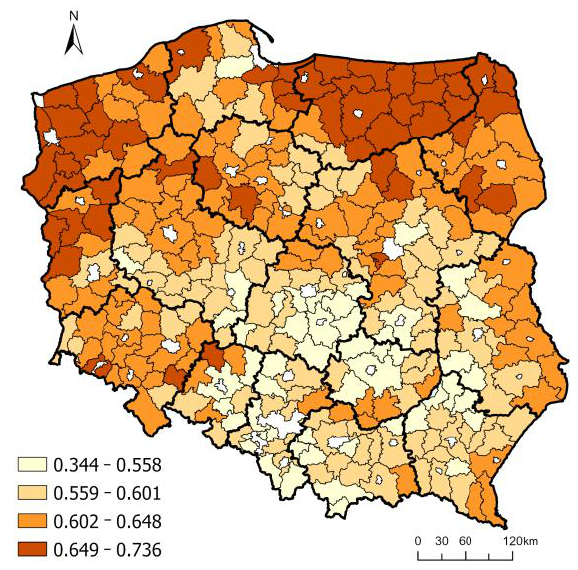
Figure 4. Agriculture—W agr . Source: own elaboration.